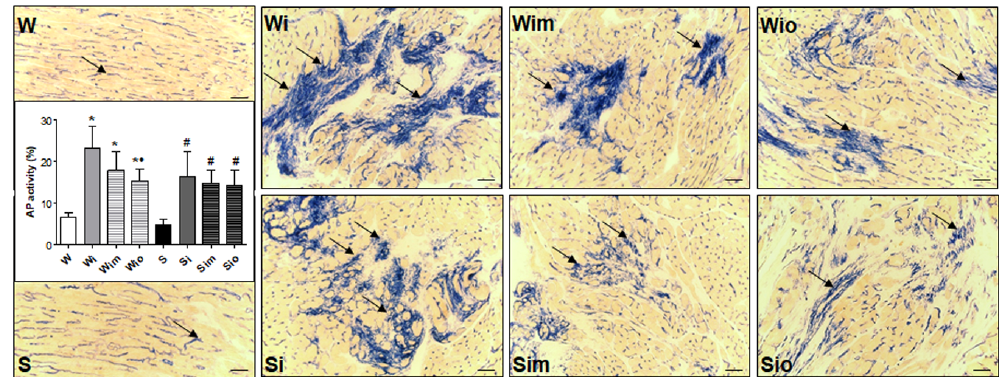
Figure 8. Reliable histochemical demonstration of AP activity (arrows) confined to endothelial cells of capillaries in control Wistar (W) as well as Spontaneously hypertensive rat (S) hearts. In addition, AP activity was increased in the foci of injury in ISO-stressed W rat hearts (Wi) as well as S rat (Si) hearts. Note reduced injured areas with AF activity due to treatment of ISO-stressed rats with melatonin (Wim, Sim) and omega-3 (Wio, Sio). Findings of quantitative image analyses are plotted on graphs. * p < 0.05 compared with W; # p < 0.05 compared with S; • p < 0.05 compared to Wi vs. Wim, Wio / Si vs. Sim, Sio. Bar 200 µm.